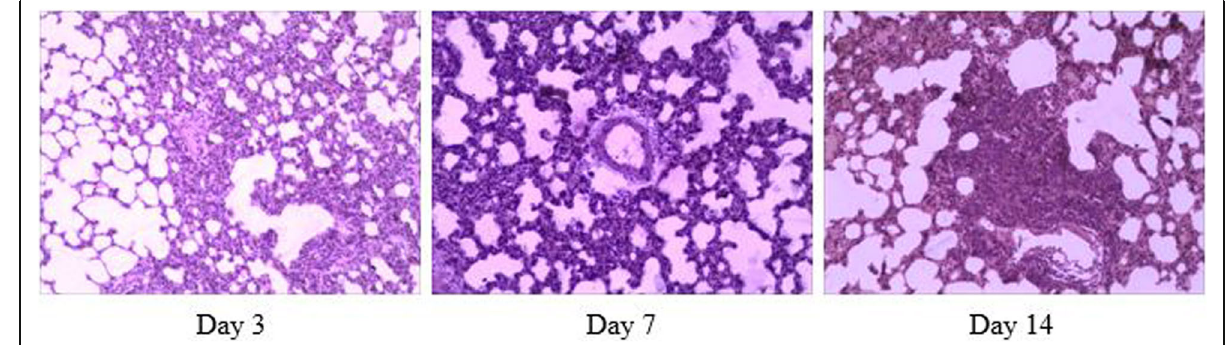
Fig. 6 Lung histopathological observation of STRE treated